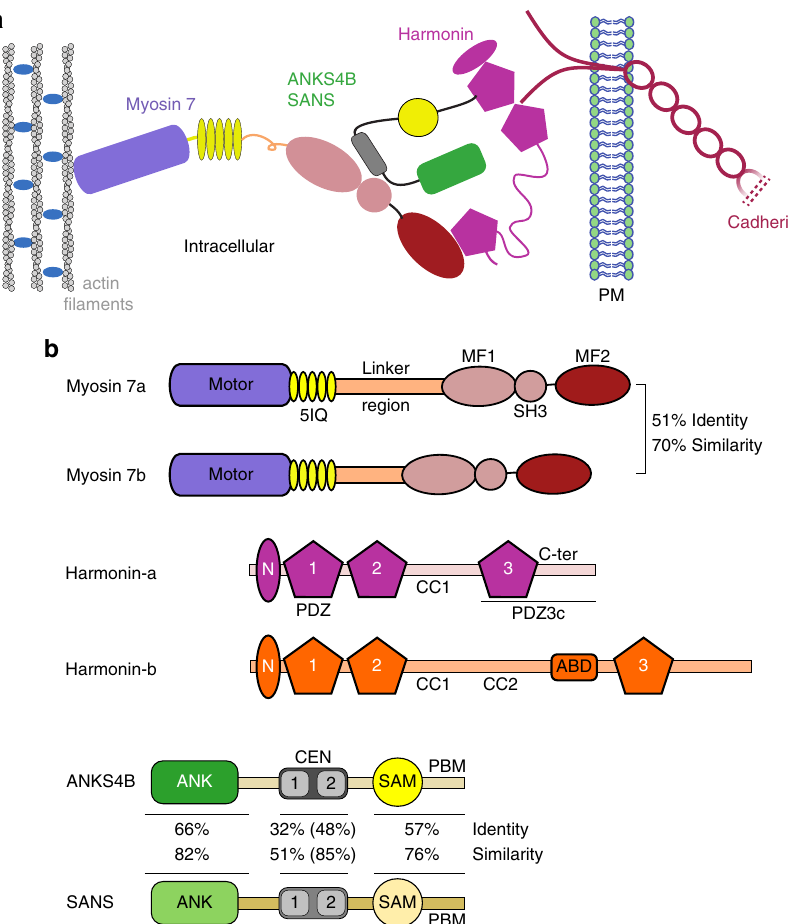
Figure 1 | Shared components of epithelial cell apical tip link complexes. ( a ) Diagram of the ternary, Myo7-based complex that links cadherins to the actin cytoskeleton in stereocilia tip links or microvilli showing the known domain interactions among partners. ( b ) Schematic illustration of Myosin 7a, Myosin 7b, Harmonin-a and -b, ANKS4B and SANS ( USH1G ). Harmonin-a stands for both a1 and a2 isoforms. Harmonin-b represents only the b2 and b3 isoforms. Harmonin-c is not shown. Harmonin-b has an additional predicted coiled-coil region (CC2), an actin binding domain (ABD), and a divergent 47aa long C-terminal extension. Although harmonin isoforms share identical N-ter, PDZ1, 2 and 3, and the CC1, in order to highlight the different functional impact between harmonin-a and -b we represent them in different colours in all figures. The percentage of identity and similarity between the Myo7 tails and between the individual ANKS4B and SANS domains are shown. The CEN domain of ANKS4B/SANS is comprised of two highly conserved CEN regions (labelled 1 and 2) connected by a short linker (see also Fig. 3a). The per cent identity and similarity when only CEN1 and CEN2 regions are taken into account are shown in